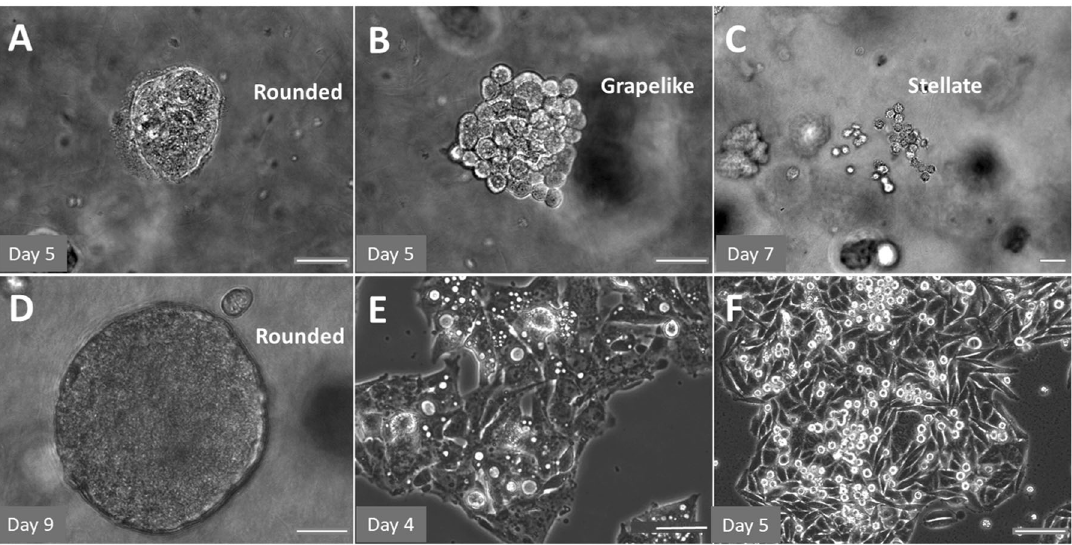
Fig. 2 Physiological spheroids formed in 3D PGmatrix culture. Spheroids of SW480 colorectal cancer cells ( A rounded, B grape-like, C stellate) and spheroids of HepG2 liver cancer cells ( D rounded) cultured in 3D PGmatrix and 2D cultures of HepG2 ( E ) and SW480 cells ( F ), scale bar, 20